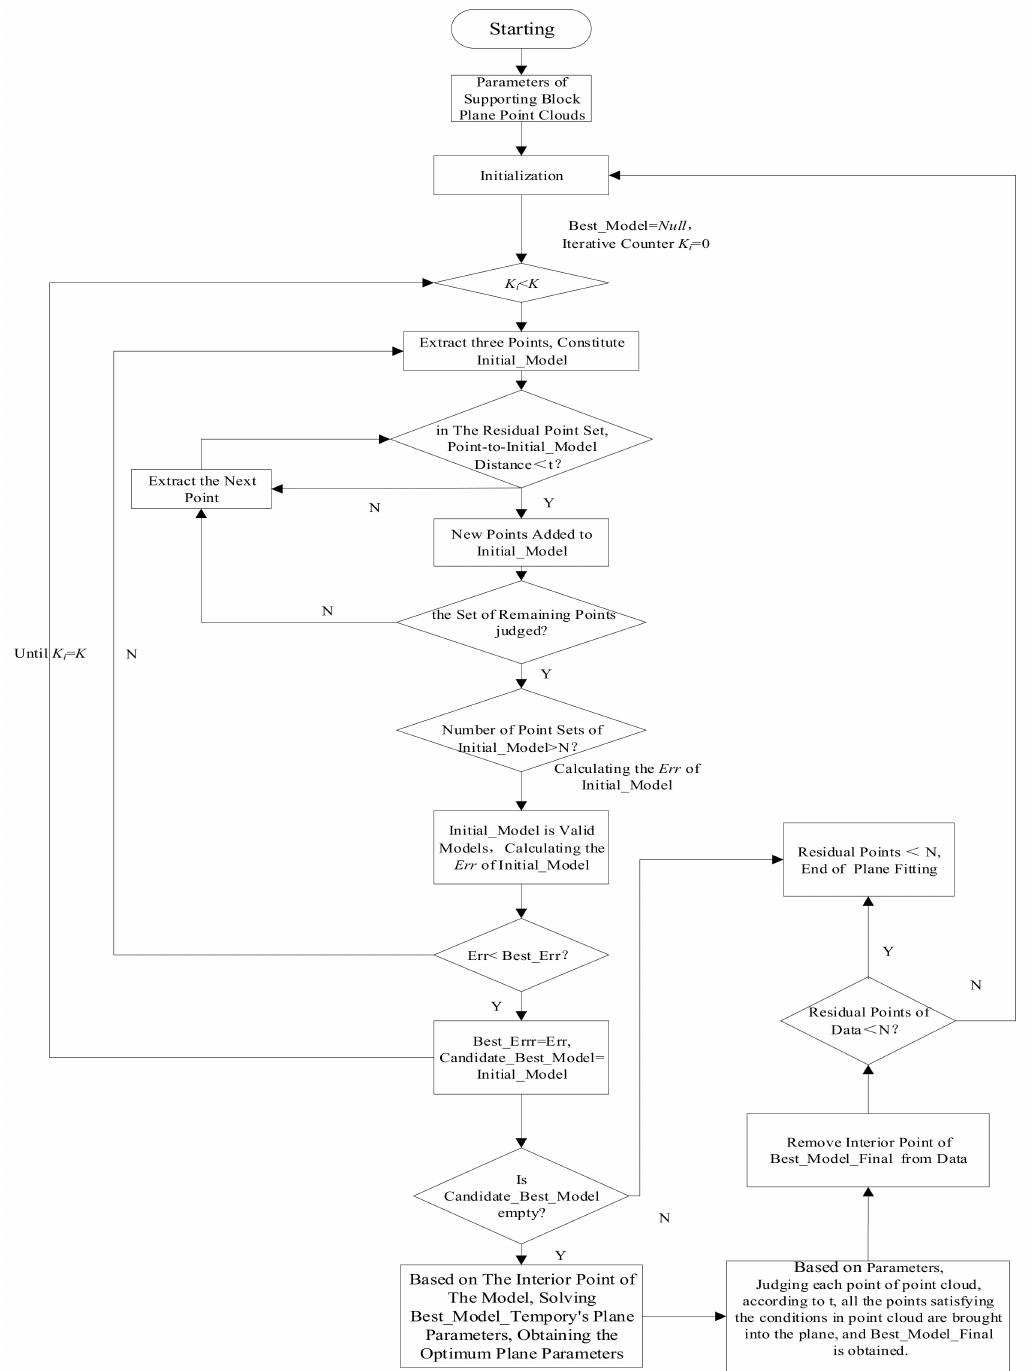
Figure 6. Improved RANSAC algorithm for planar point cloud fitting